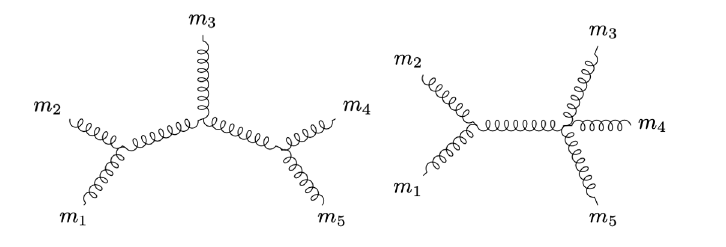
Figure 6 . Five point diagrams for the general